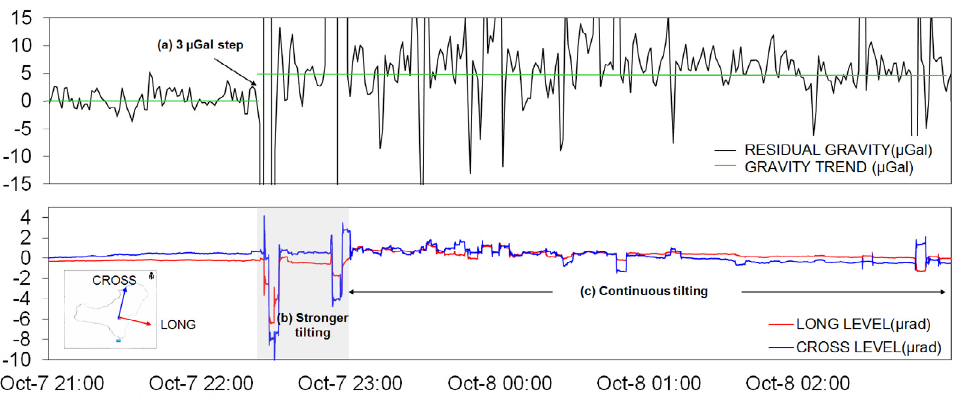
Figure 5. (a) Residual gravity record (µGal) filtered at 1 minute and (b) long and cross level values (µrad) in the period between the night of October 7, and the early morning of October 8, 2011. The inset in the lower part of the plot shows, the cross and long directions of the two levels within the gravimeter.